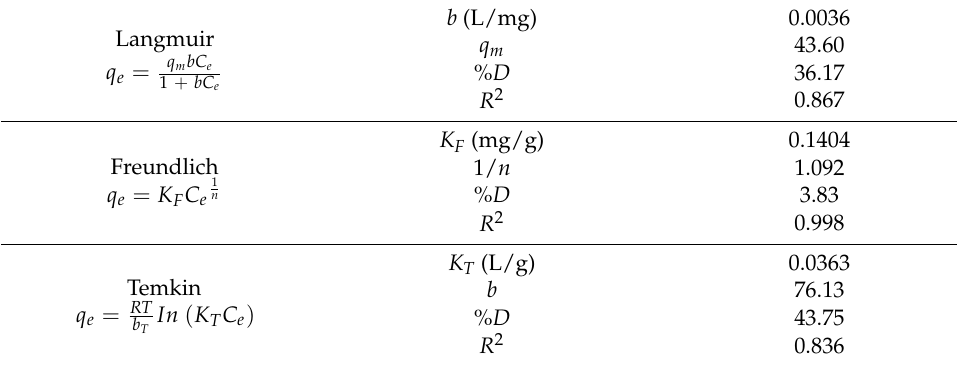
Table 4. Cd(II) adsorption isotherm parameters on alumina spheres at 1600 ◦ C.